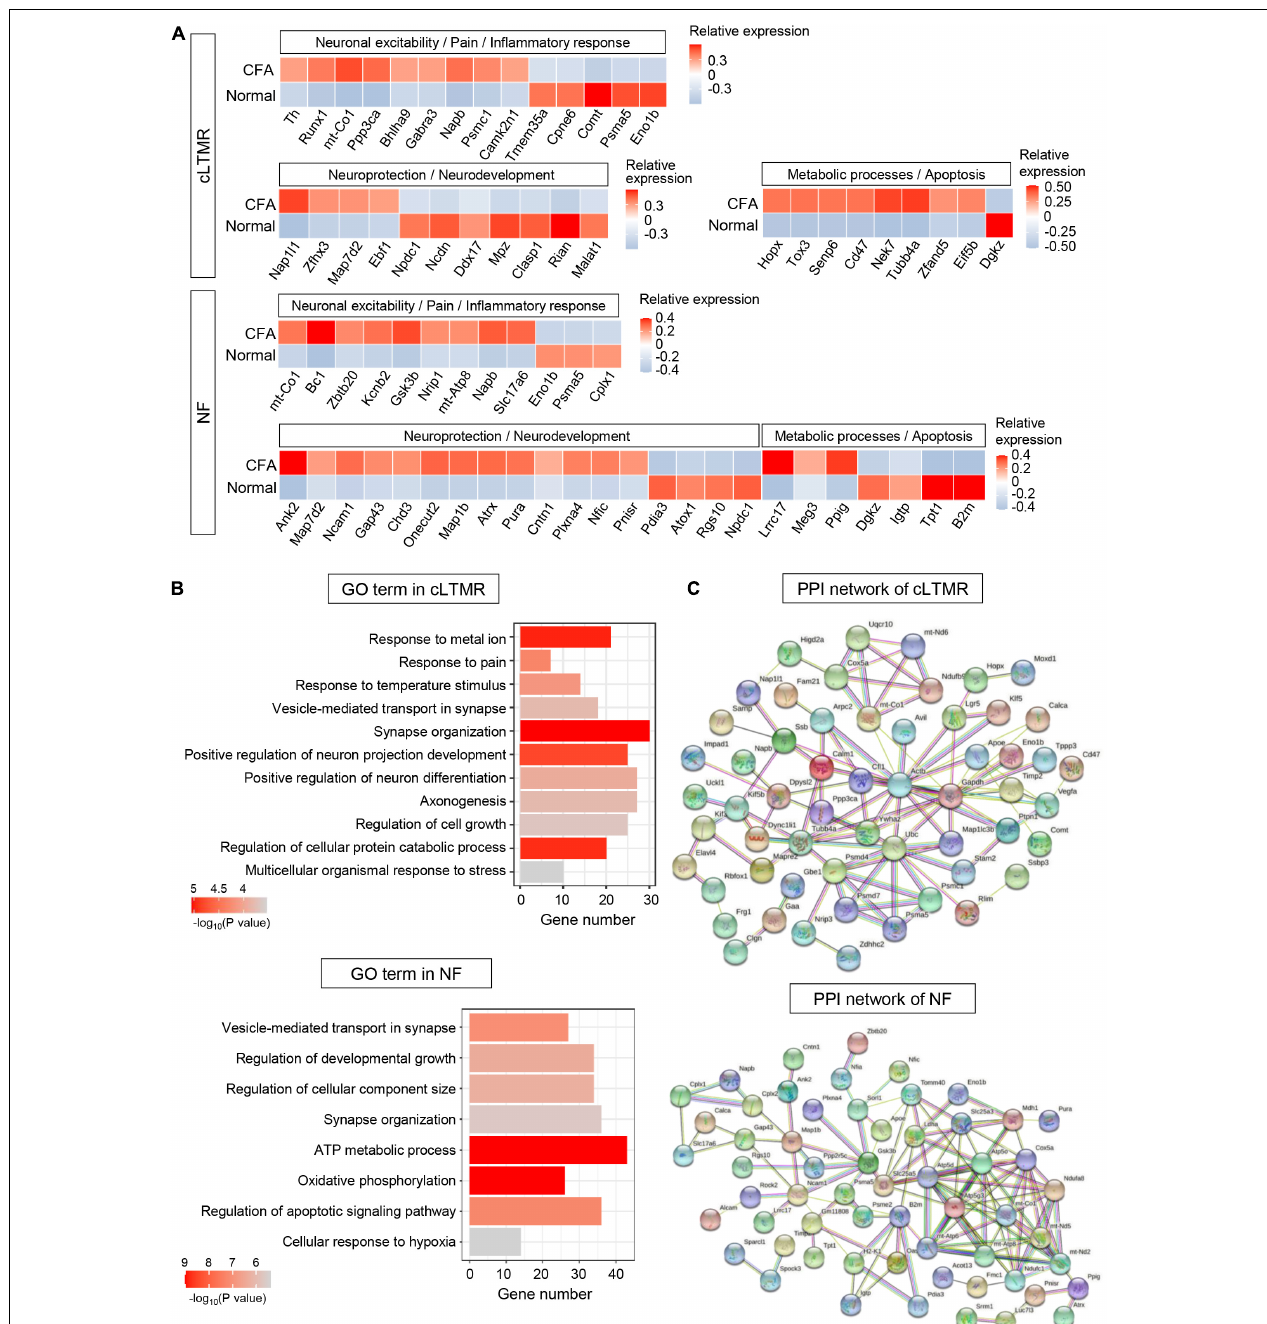
FIGURE 7 | Transcriptional responses of cLTMR and NF neurons in mouse TG to orofacial inflammation revealed by scRNA-seq. (A) Heatmap of identified DEGs within cLTMR and NF neurons under normal and orofacial inflammatory pain conditions. Red colors indicate upregulated expression level in the heatmap, while blue colors indicate downregulated expression level. (B) The enriched GO biological process terms of identified DEGs in cLTMR and NF neurons following orofacial inflammation. The number of genes is plotted as the abscissa and enriched GO biological process term is plotted as the ordinate. The colors correspond to p -value range. (C) PPI network analysis of identified DEGs in cLTMR and NF neurons following orofacial inflammation. The top hub genes in cLTMR are Actb (degree = 18), Ubc (degree = 11), Ywhaz (degree = 7), Calm1 (degree = 6), mt-Co1 (degree = 6), and Cfl1 (degree = 6), while top hub genes in NF are Atp5d (degree = 12), Cox5a (degree = 12), Atp5g3 (degree = 11), mt-Co1 (degree = 10), and B2m (degree = 8), etc. The line color indicates the type of interaction evidence, and line thickness indicates the strength of data support. Blue represents known interactions from curated databases, while purple represents experimentally determined interactions. Green, red, and royal blue represent gene neighborhood, gene fusions and gene co-occurrence, respectively. TG, trigeminal ganglion; scRNA-seq, single-cell RNA-sequencing; DEGs, differentially expressed genes; CFA, complete Freund’s adjuvant; NF, Nefh -positive neurons; cLTMR, C-fiber low-threshold mechanoreceptors; PPI, protein–protein